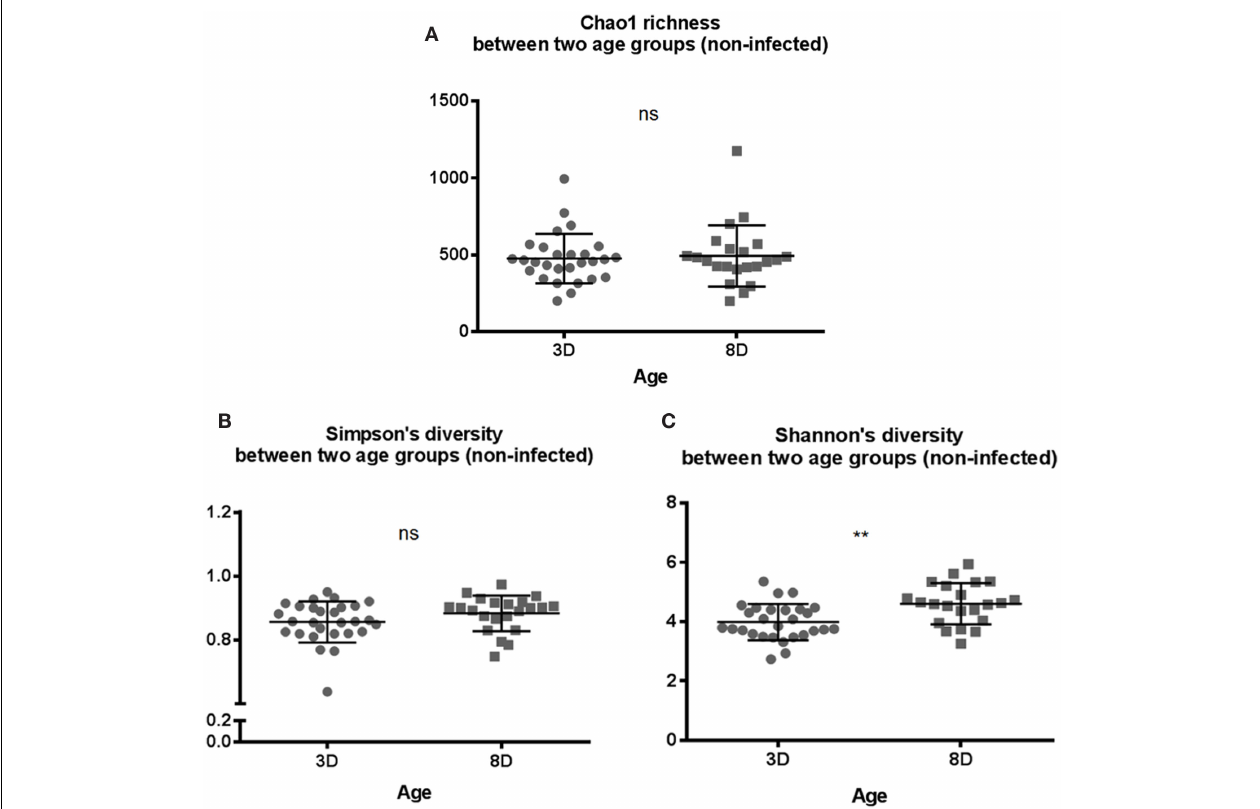
FIGURE 1 | Microbial alpha diversity between two age groups of 3days old (3D) and 8days old (8D) . Alpha diversity metrics of (A) Chao1 richness estimate, (B) Simpson’s diversity, and (C) Shannon’s diversity index were analyzed. Shannon’s diversity index was significantly higher for 8-days-old chicks suggesting that as number of species increases, there is more even distribution of species in the community compared to 3-days-old chicks. All three diversity metrics were evaluated using Mann–Whitney U test. ** p value < 0.01 and ns =